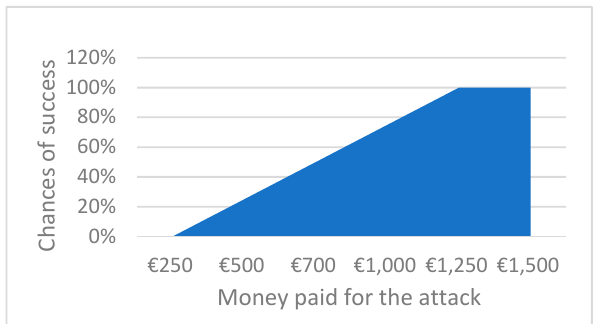
Figure 12 . Success of Monopolist attacks .